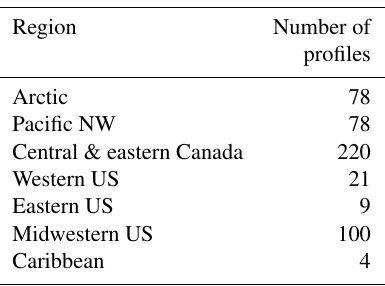
Figure 4. Location of the 510 selected boreholes. The colors repre- sent the maximum depth of each borehole. Table 2. Distribution of borehole between regions as defined for PAGES2k (McKay,